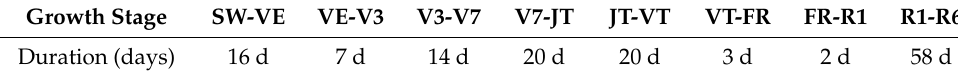
Table 1. Duration of each stage of maize in Northeast